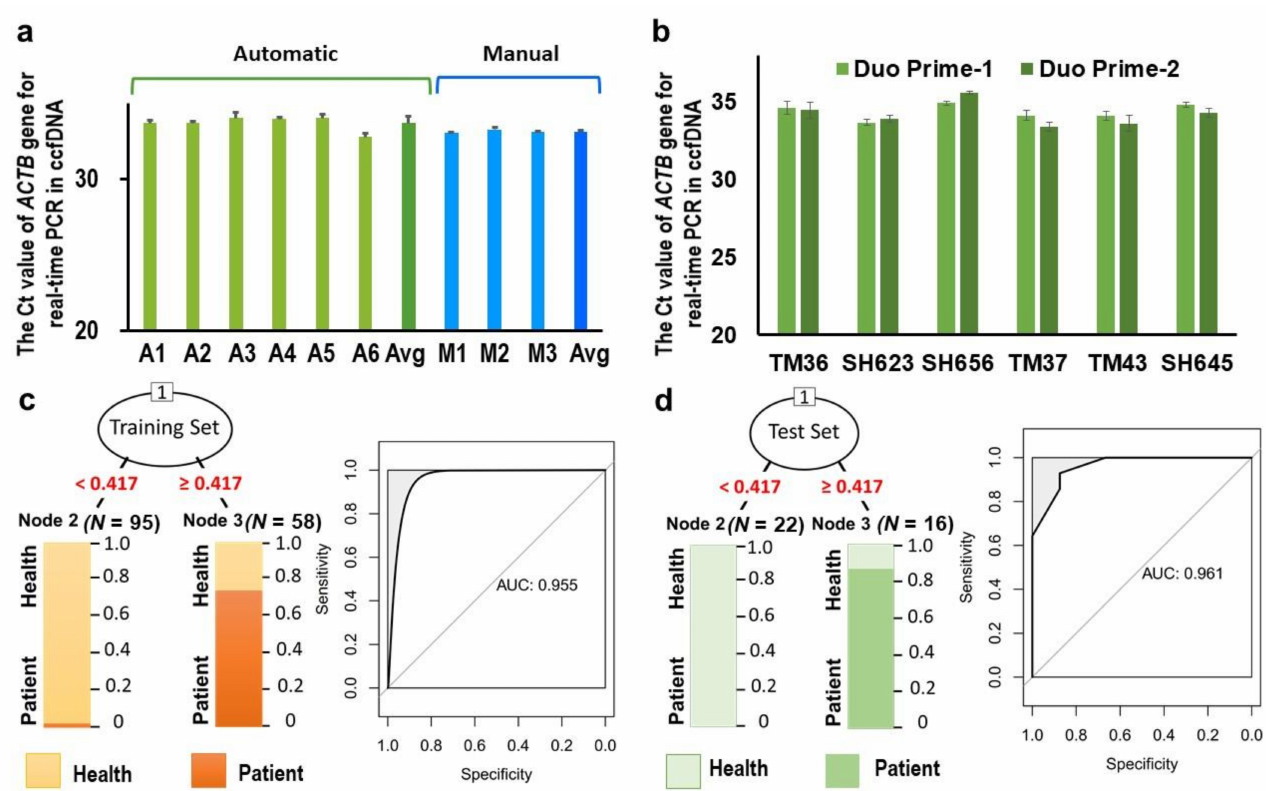
Figure 4. Stability and clinical validation of the automatic detection process for circulating methylated ccfDNA. ( a ) The PCR Ct value of the relative ccfDNA methylation level of the ACTB gene was used to compare the repeatability between the automatic process and manual process. ( b ) The PCR Ct value of the relative ccfDNA methylation level of the ACTB gene was used to compare the stability of the process in independent wells by parallel testing in two independent KingFisher™ Duo Prime Purification machines. ( c ) The decision tree model and ROC curve for the prediction of breast cancer in the training set by Recursive Partitioning and Regression Trees. ( d ) The decision tree model and ROC curve for the prediction of breast cancer in the test set by Recursive Partitioning and Regression